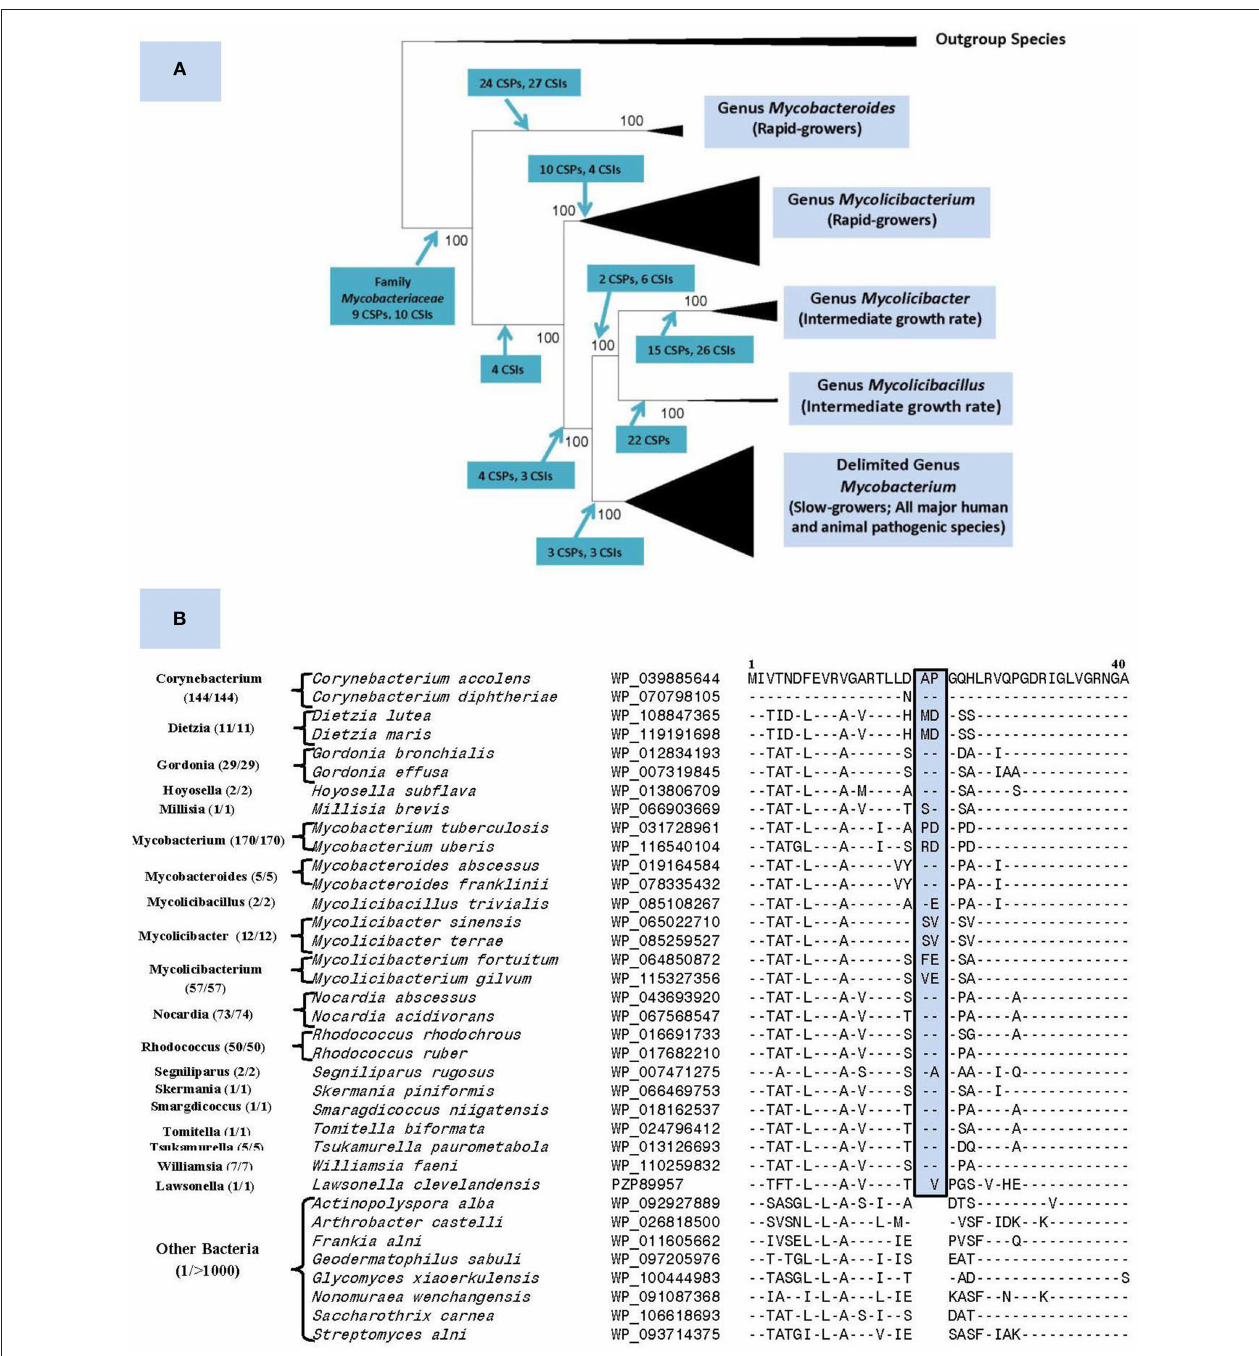
FIGURE 1 | (A) A summary diagram showing the five main clades within the family Mycobacteriaceae , now recognized as distinct genera, seen in different phylogenetic trees. The molecular synapomorphies consisting of conserved signature indels (CSIs) and conserved signature proteins (CSPs), which distinguish different clades are marked on the nodes. The members of these clades/genera also differ in their growth rates. (B) Partial sequence alignment of the ABC-F family ATP-binding cassette domain-containing protein showing a 2 aa insert in a conserved region that is commonly and uniquely present in different members of the order Mycobacteriales . The dashes (–) in the alignment show identity with the amino acids shown on the top line. The numbers with the genus name refer to different unique strains for which sequences were examined. The sequence information is shown for only 1–2 representative species from different genera that are part of this order and very few outgroup species. However, this CSI is not found in other Actinobacteria or other examined bacteria (see Figure S1 ) with the possible exception of Kroppenstedtia sanguinis (a Firmicute). This CSI as well as a number of other CSIs and CSPs for this order were described in our earlier work (Gao and Gupta, 2012) based on limited sequence information and most of them are still distinctive characteristics of this order.